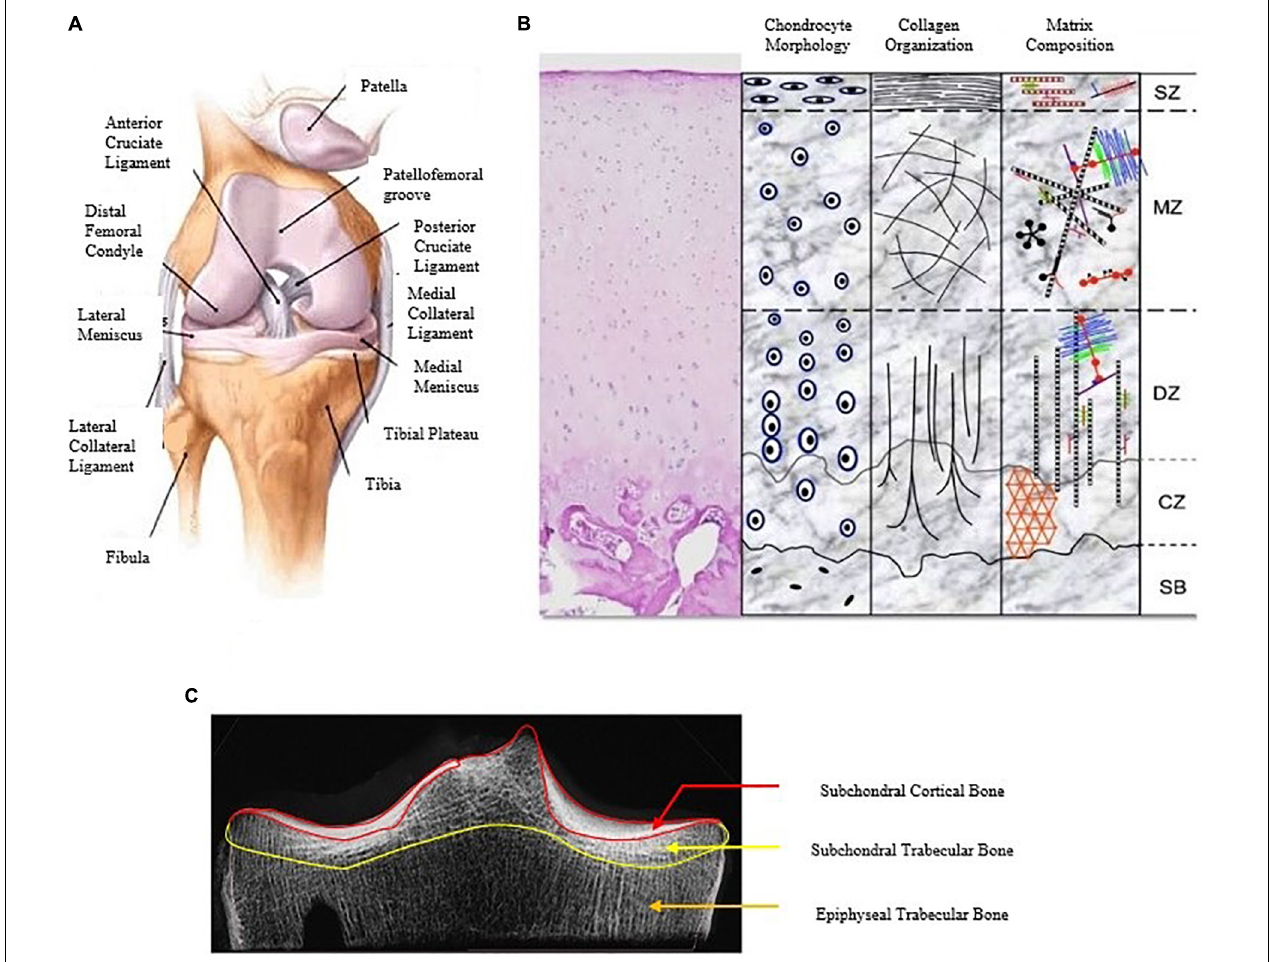
FIGURE 1 | A detailed description of the human knee joint with the different constituents of the knee joint (A) (Islam, 2019), the different layers of articular cartilage showing variation in chondrocyte shape, collagen orientation, and matrix distribution (B) (Di Bella et al., 2015) and the different regions of the subchondral bone (C) (modified from Yamada et al.,